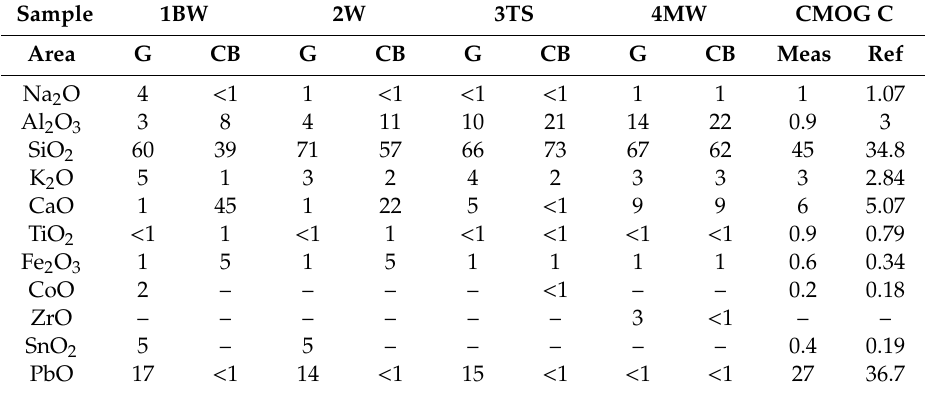
Table 2. Major and minor oxide components of the glaze and ceramic body of the tile samples in wt.(%). Sample